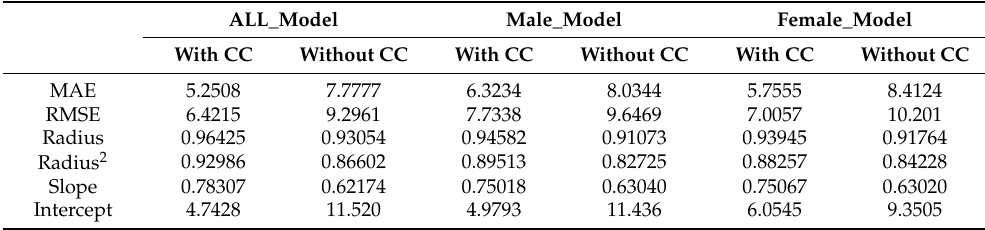
Table 6. Change in accuracy before and after deletion of the corpus callosum region.